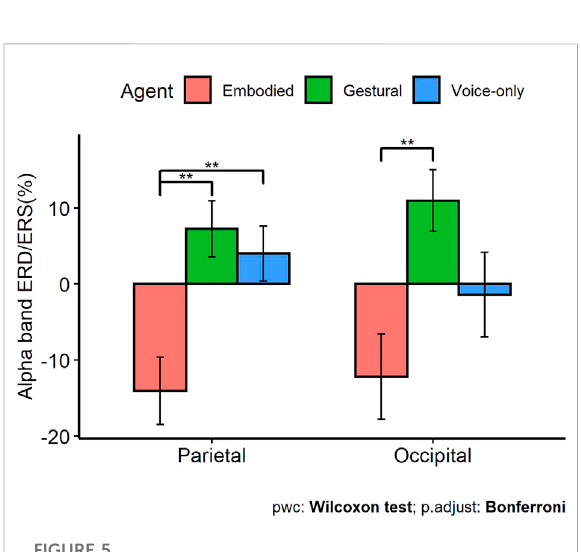
FIGURE 5 Alpha band ERD/ERS (Error bars represent the standard error of the mean; Statistical signi fi cance: ** ( p <